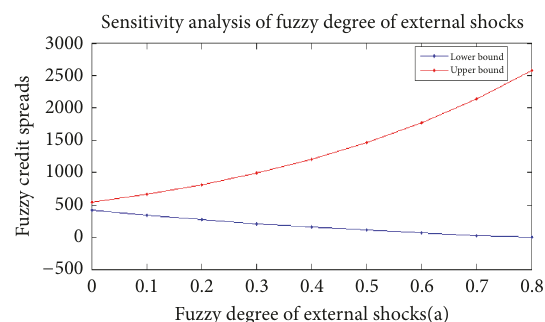
Figure 5: The dynamics between fuzzy credit spreads and subjective reliability.